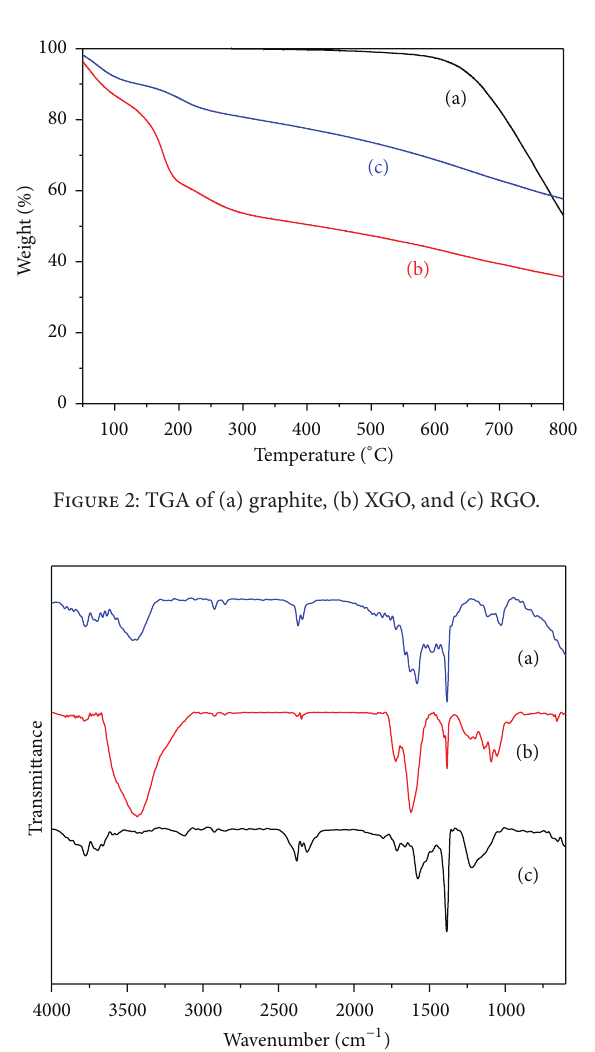
of oxygen functional groups after the oxidation process. The peak at 1627 cm −1 is related to the vibrations of adsorbed water molecules. After the XGO was reduced, hydroxyl and alkoxy groups were significantly decreased (Figure 3(c)), and the phenol C=C ring stretching at 1585 cm −1 was present [10].